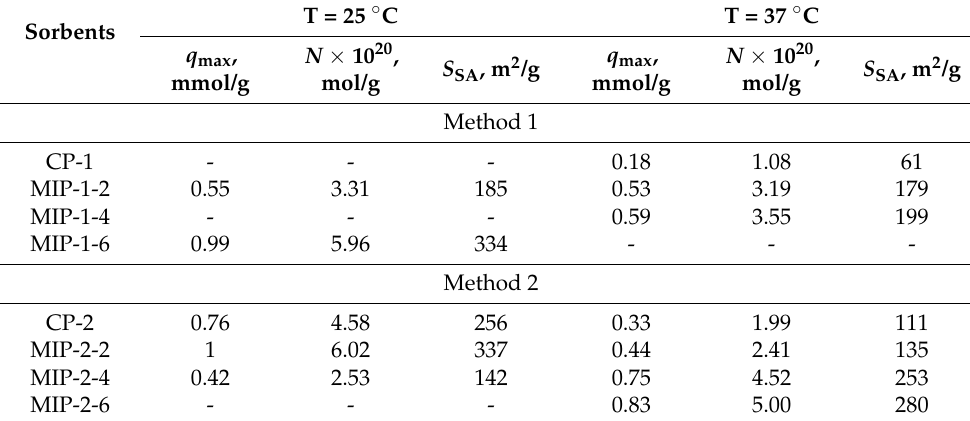
Table 6. Areas of sorption surfaces of studied polymers in a solvated